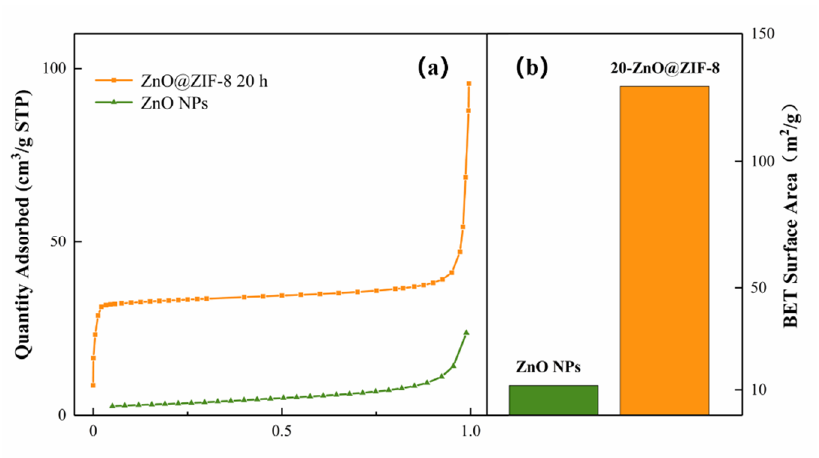
Figure 9. Adsorption/desorption isotherms of ZnO NPs ( a ) and 20-ZnO@ZIF-8 and BET specific surface area ( b ).